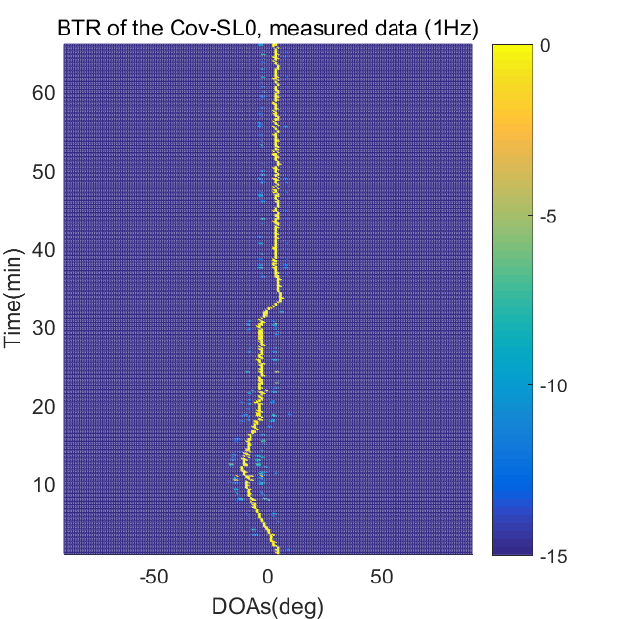
Figure 13. Bearing time records of the proposed scheme: 66 min, pilot signal frequency = 1